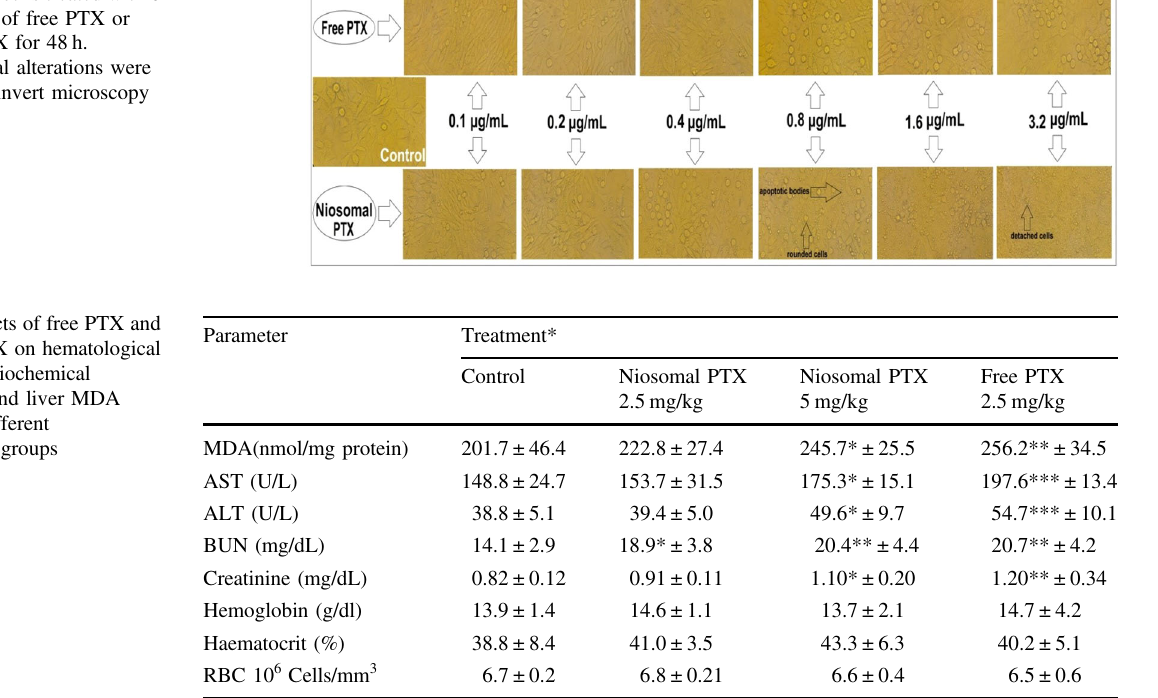
Fig. 8 MCF7 cells treated with 0 to 3.2 µg/mL of free PTX or niosomal PTX for 48